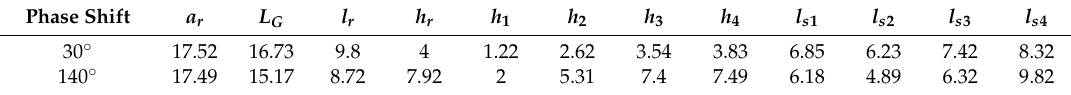
Table 2. Final mechanical dimensions of the manufactured 30 ◦ and 140 ◦ DPSs (units in